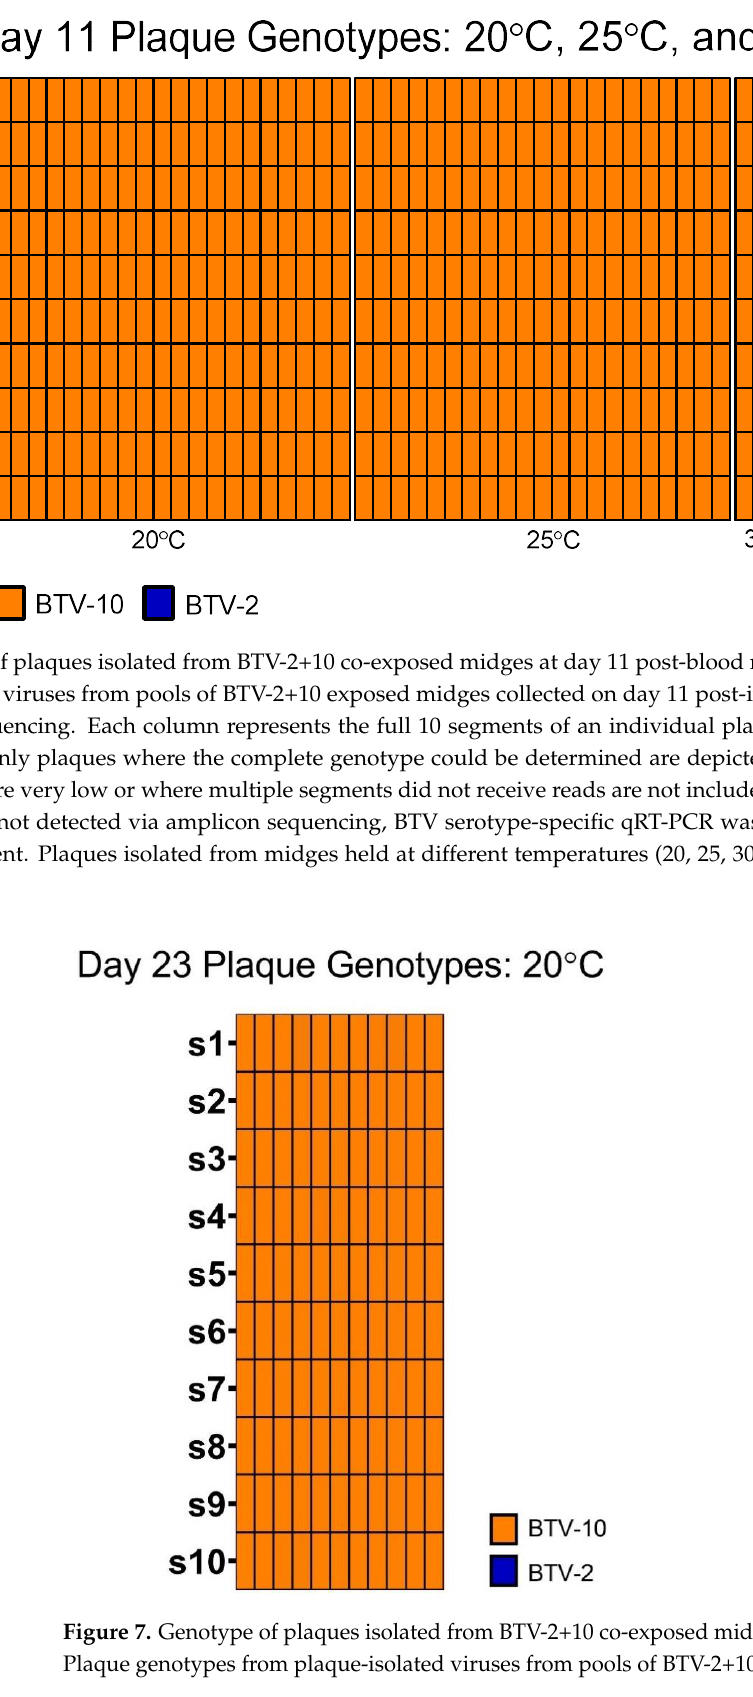
Figure 7. Genotype of plaques isolated from BTV-2+10 co-exposed midges at day 23 post-blood meal. Plaque genotypes from plaque-isolated viruses from pools of BTV-2+10 exposed midges collected